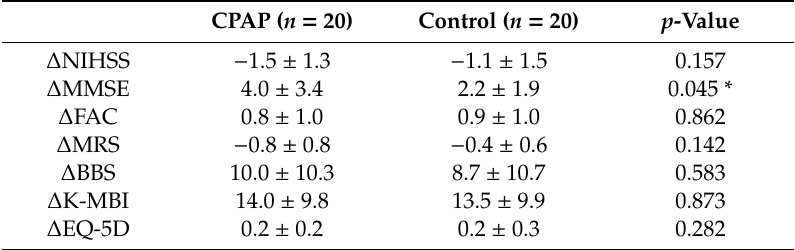
Table 2. Comparison of clinical outcome between CPAP and control